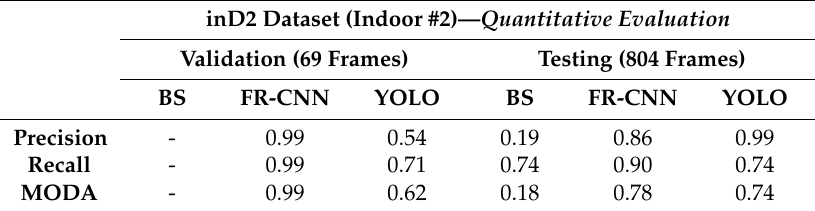
Table 4. Quantitative results from the indoor dataset inD2.